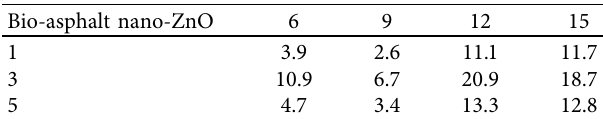
Table 2: Several signifcant-level softening point increment per- centages